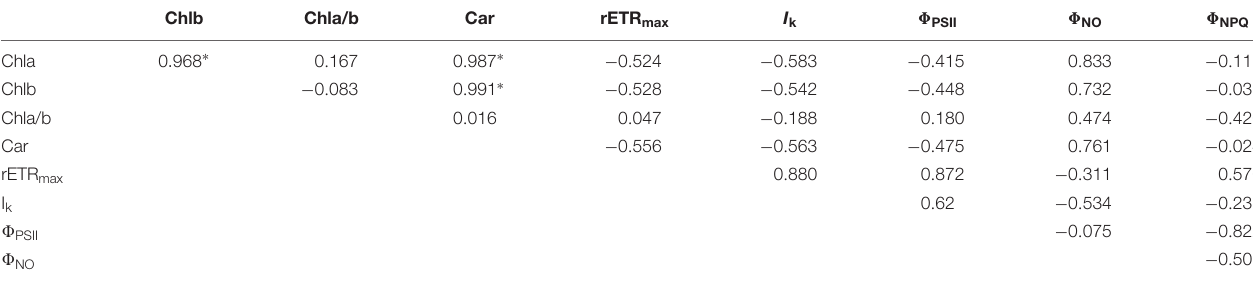
TABLE 4 | The Pearson correlation between nine pigment-related leaf traits in the eight populations.